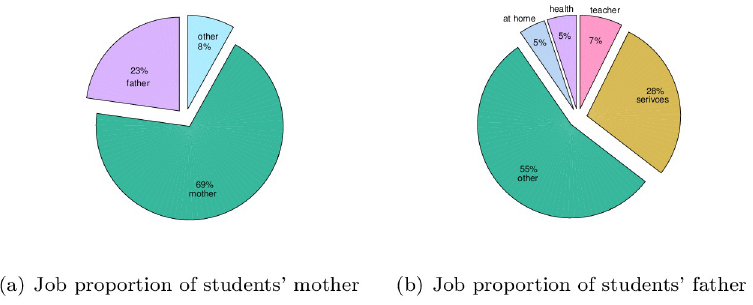
Fig 10. Job of the students’ parents. (a) Job proportion of students’ mother, (b) Job proportion of students’ father.